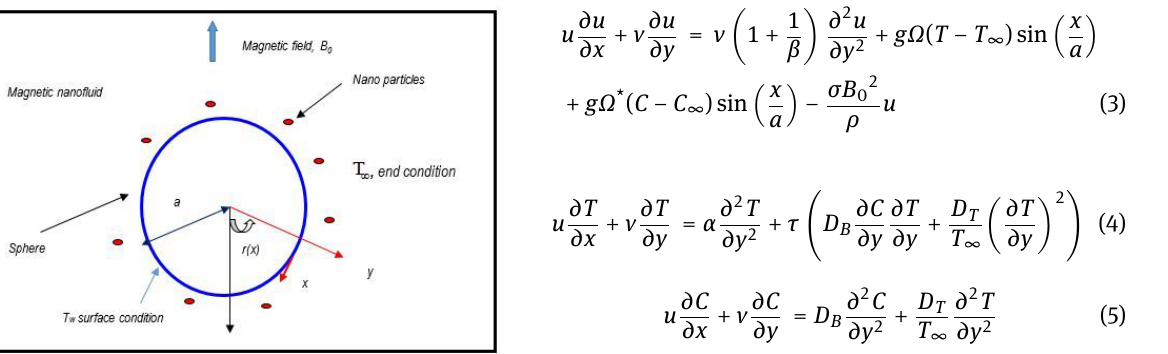
Fig. 1: Physical model and coordinate system